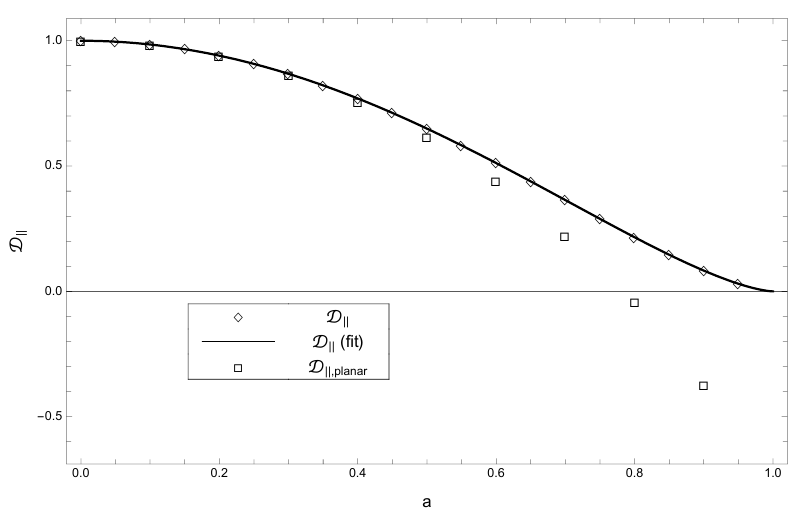
Figure 11 . Momentum di(cid:11)usion in a simply spinning black hole versus the planar limit black brane. Displayed is the di(cid:11)usion coe(cid:14)cient D extracted in the momentum di(cid:11)usion (vector per- jj turbation) sector from the hydrodynamic QNM of the (cid:12)eld h +3 (circles) of the black hole. It is compared to the di(cid:11)usion coe(cid:14)cient of the (cid:12)eld h xy (dots) of the planar limit black brane. The planar limit breaks down around a = 0 : 7, where the planar limit black brane QNM acquires a positive imaginary part, rendering that planar limit black brane unstable. The black hole however is stable throughout the whole regime from a = 0 to (near) extremality a (cid:25)